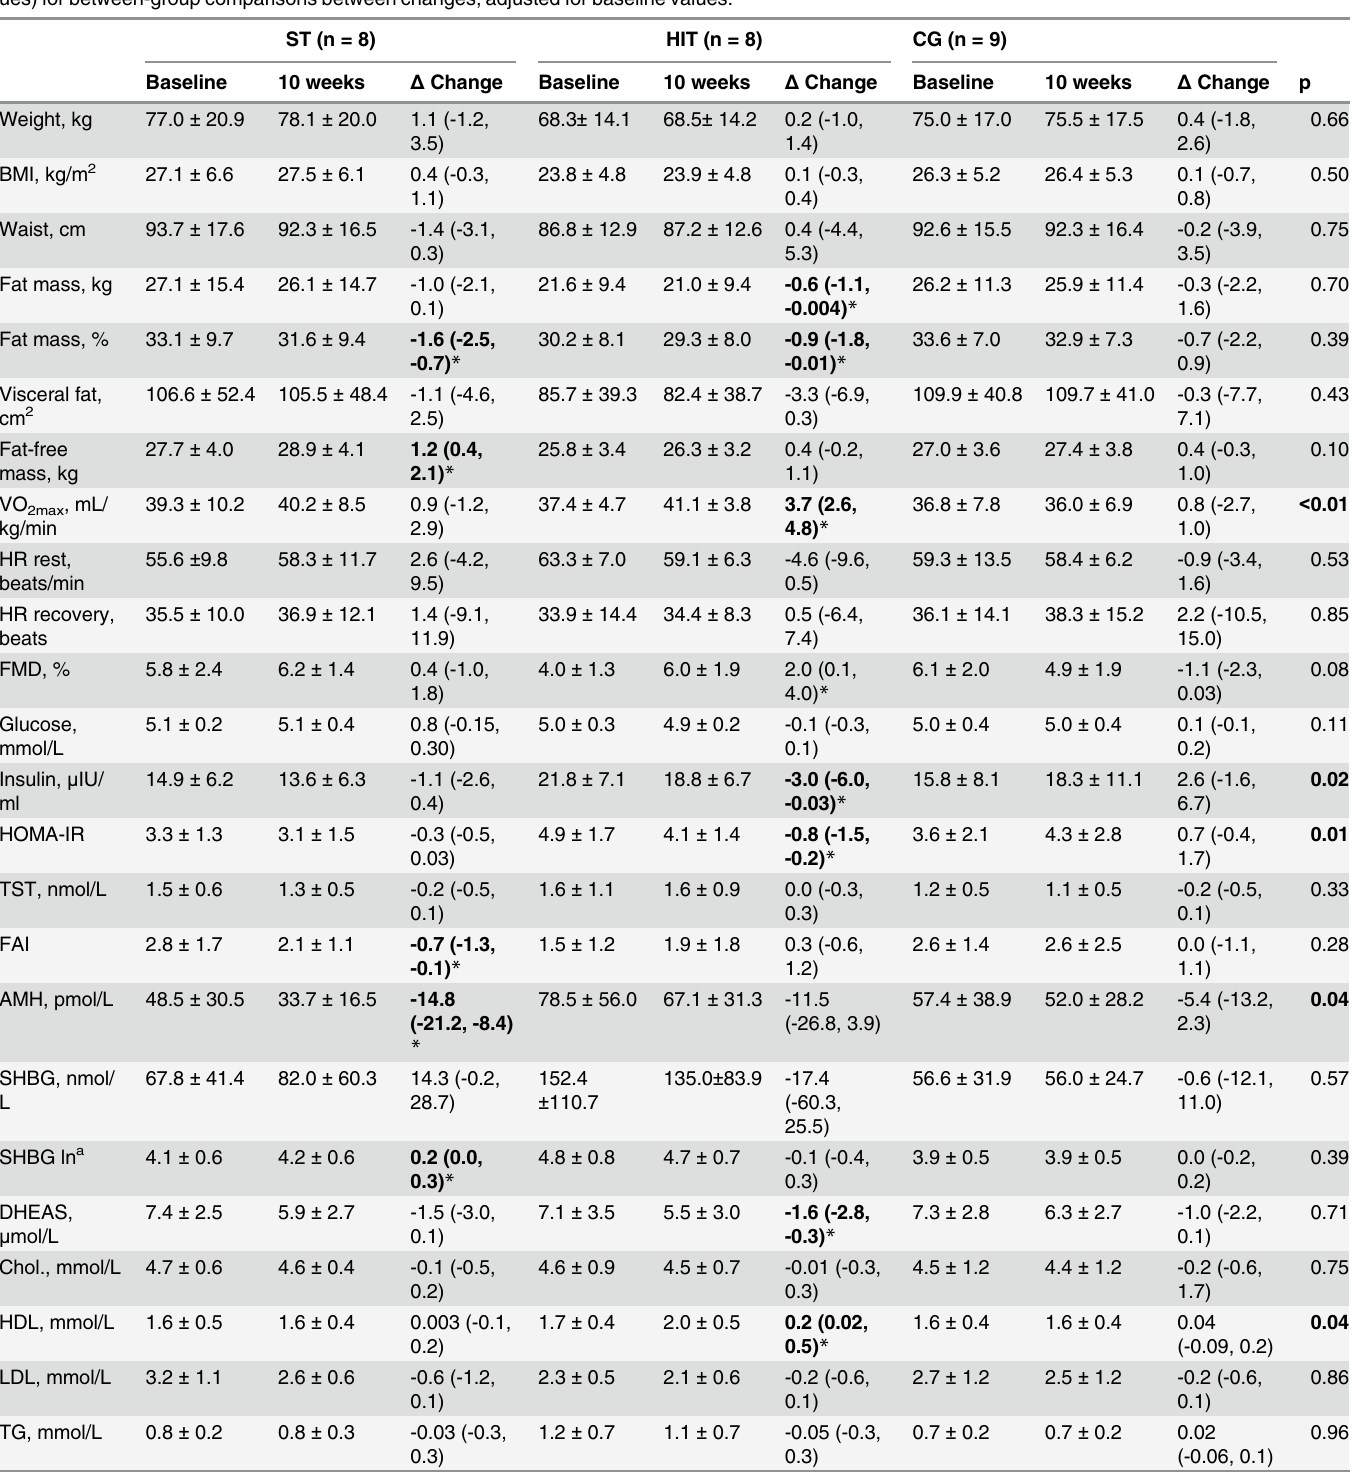
Table 2. Outcome measures at baseline and after intervention (10 weeks) in women who completed follow-up testing. Observed values as means ± standard deviation (SD). Delta ( Δ ) change from baseline to 10 weeks after adjustment for baseline values, with 95% confidence interval (CI). P (val- ues) for between-group comparisons between changes, adjusted for baseline